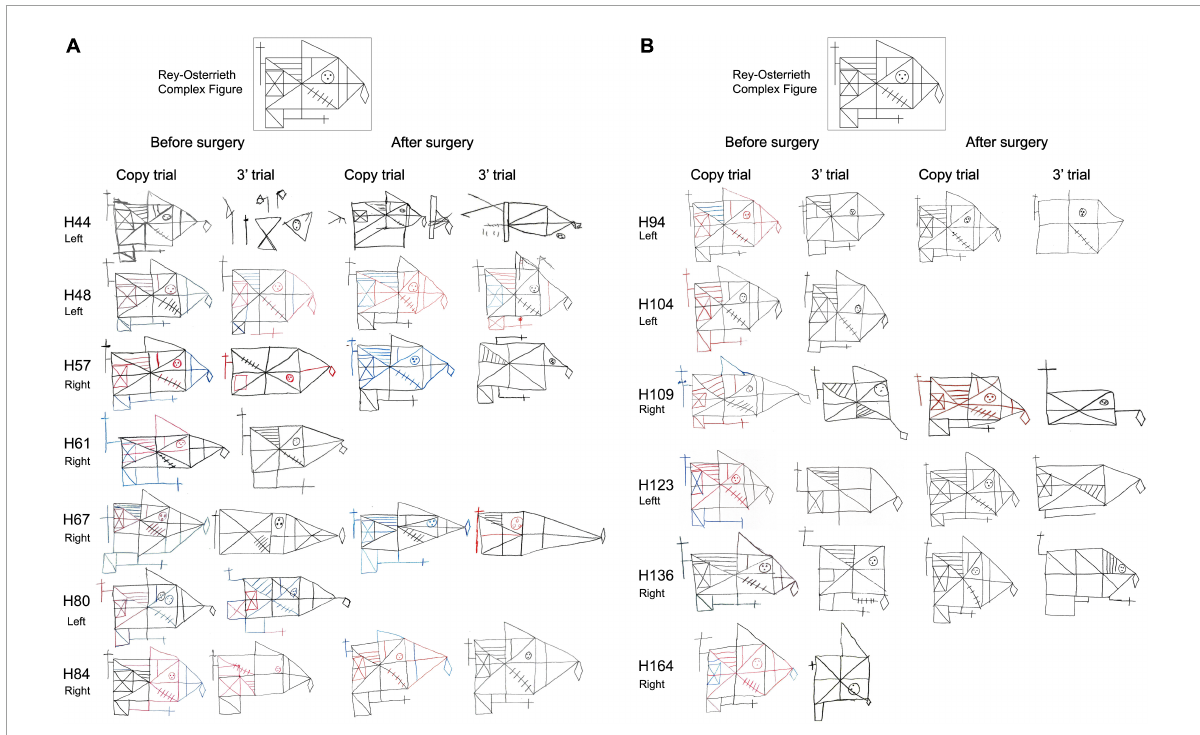
FIGURE6 (A) Before and after surgery ROCF drawings (copy and after 3 min trials) from HS-patients that became seizure-free after surgery. All patients except H44 y and H61 were right-handed. Patient H61 was not evaluated after surgery. Patient H80 did not perform the tests after surgery. The size of the original drawings has not been considered. (B) Before and after surgery ROCF drawings (copy and after 3 min trials) from HS-patients that became seizure-free after surgery. All patients were right-handed. Patient H104 and H164 were not evaluated after surgery. The size of the original drawings has not been